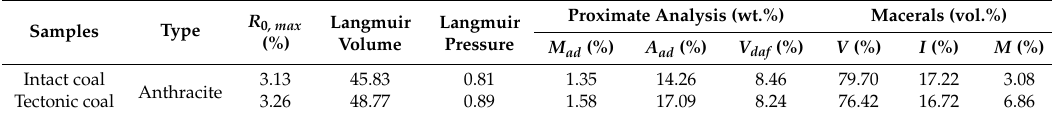
Figure 1. Map showing the location of the Sihe coal mine, the mine from which the samples were collected. Table 1. Maximum vitrinite reflectances, Langmuir volume and pressure, macerals, and partial proximate analyses for the coal samples used in this study.